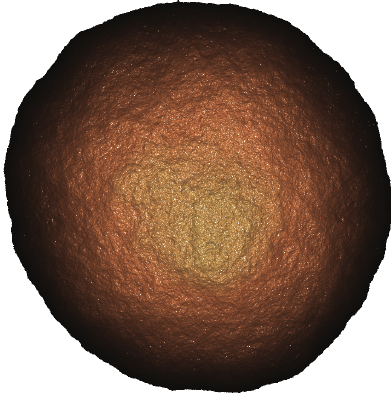
Figure 2: Numerically generated rough sphere, 𝐻 = 0.7